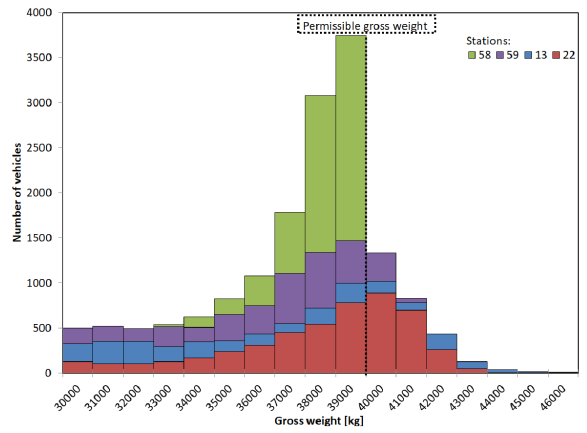
Figure 9: Gross weight distribution of category 9 vehicles for partic- ular WIM